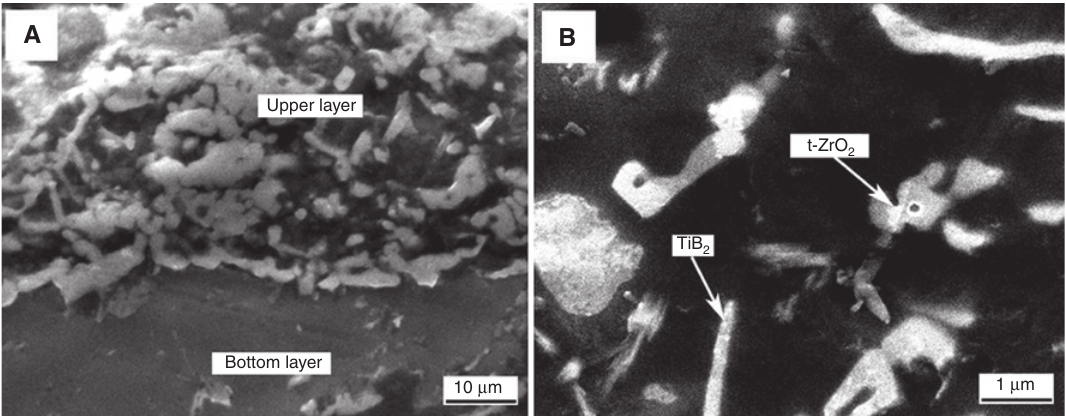
Al-B C-YPSZ-Al 3 4